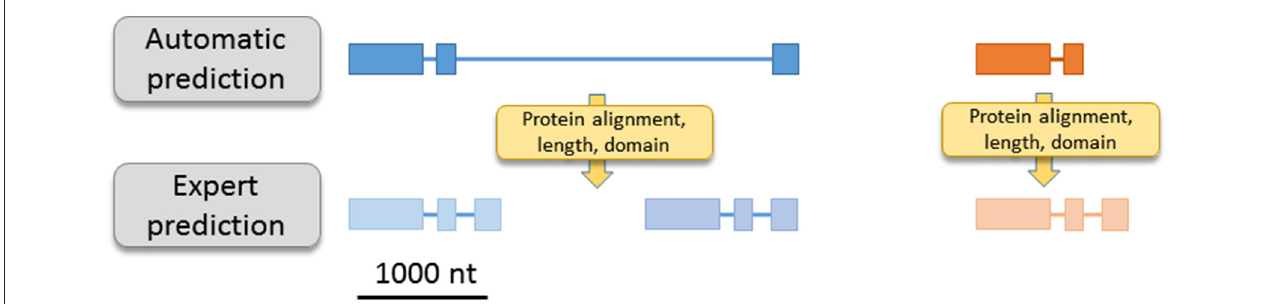
FIGURE 1 | Illustration of two usual mis-prediction. For example, automatic prediction can generate one ORF result of two independent ORF fusion (left part) or partial ORF with a missing/partial exon (right part). Sequence homology, sequence length, domain detection… allow a large reduction of automatic bias.